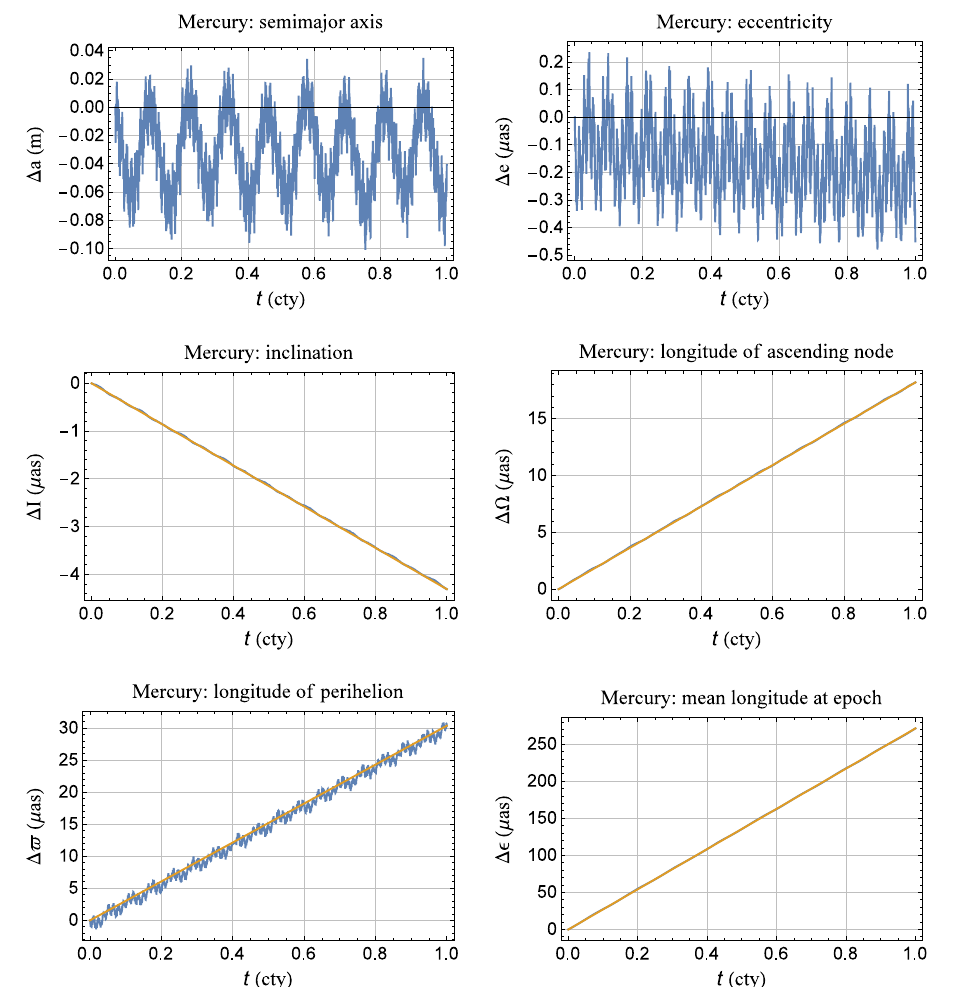
Fig. 1 Numerically integrated time series, in blue, of the shifts of the semimajor axis a , eccentricity e , inclination I , longitude of the ascend- ing node (cid:2) , longitude of perihelion (cid:3) , and mean longitude at epoch (cid:4) of Mercury induced by the sum of all the fifteen 1pN perturbing accel- erations of Eqs. (1) to (3) for X ranging from Venus to Saturn over a time span 1 cty long. The units are m for a and microarcseconds ( μ as) for all the other orbital elements. They were obtained for each orbital element as differences between two time series calculated by numeri- cally integrating the barycentric equations of motion of all the planets